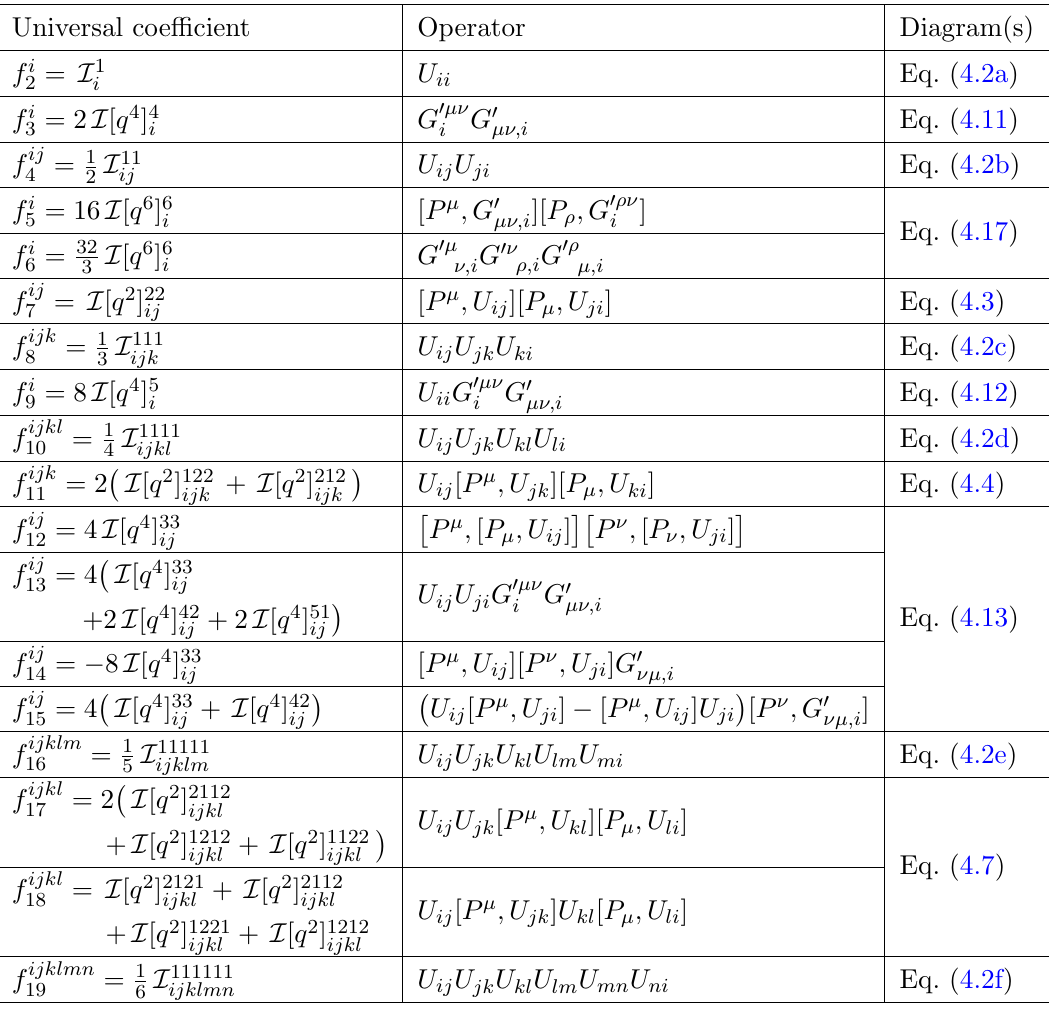
Table 5 . List of universal coe(cid:14)cients in terms of the master integrals de(cid:12)ned in eq. (3.26) (Column 1). The UOLEA master formula for one-loop matching reported in [8] is reproduced by adding up traces of the operators in Column 2 with the corresponding universal coe(cid:14)cients, and multiplying the overall factor (cid:0) ic s ; see eq. (4.1). The covariant diagrams used to compute each universal coe(cid:14)cient are listed in Column 3. See appendix B for expressions of the universal coe(cid:14)cients in terms of heavy particle